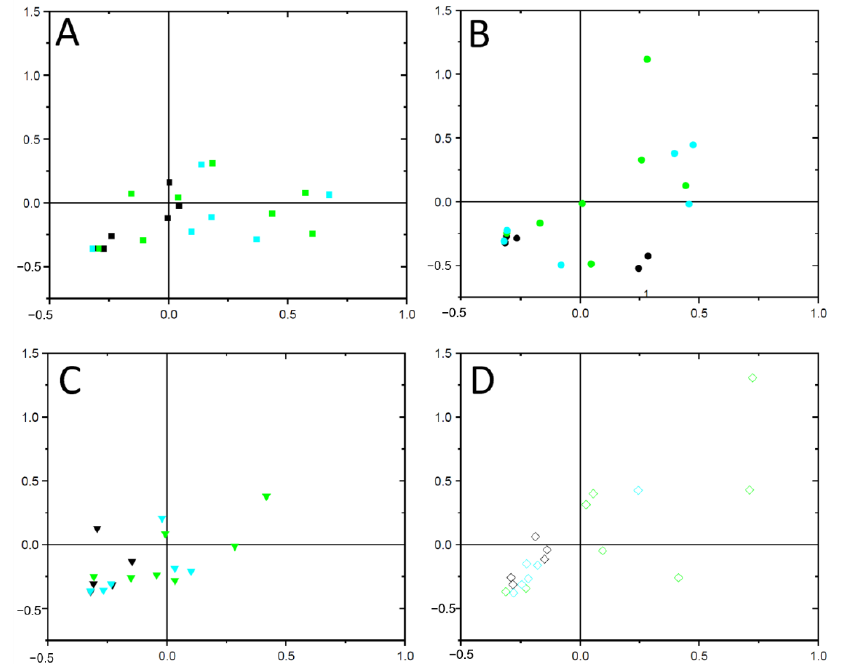
Figure 2. Correspondence analysis of the bacterial skin microbiome retrieved from AD patients after daily synbiotic (black), prebiotic (green) or placebo bath (cyan) before start ( A , ■ ), and after 9 ( B , ●), 11 ( C , ▼ ) and 14 days of bath treatment ( D , ◊). The eigenvalues of the 1st and 2nd axes were λ 1 = 0.53 and λ 2 = 0.48.